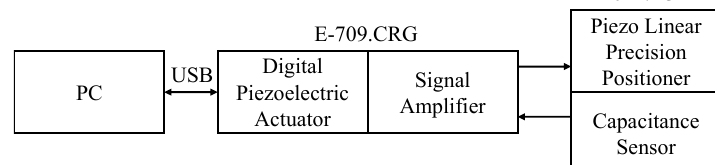
Figure 3. Experimental platform communication diagram.